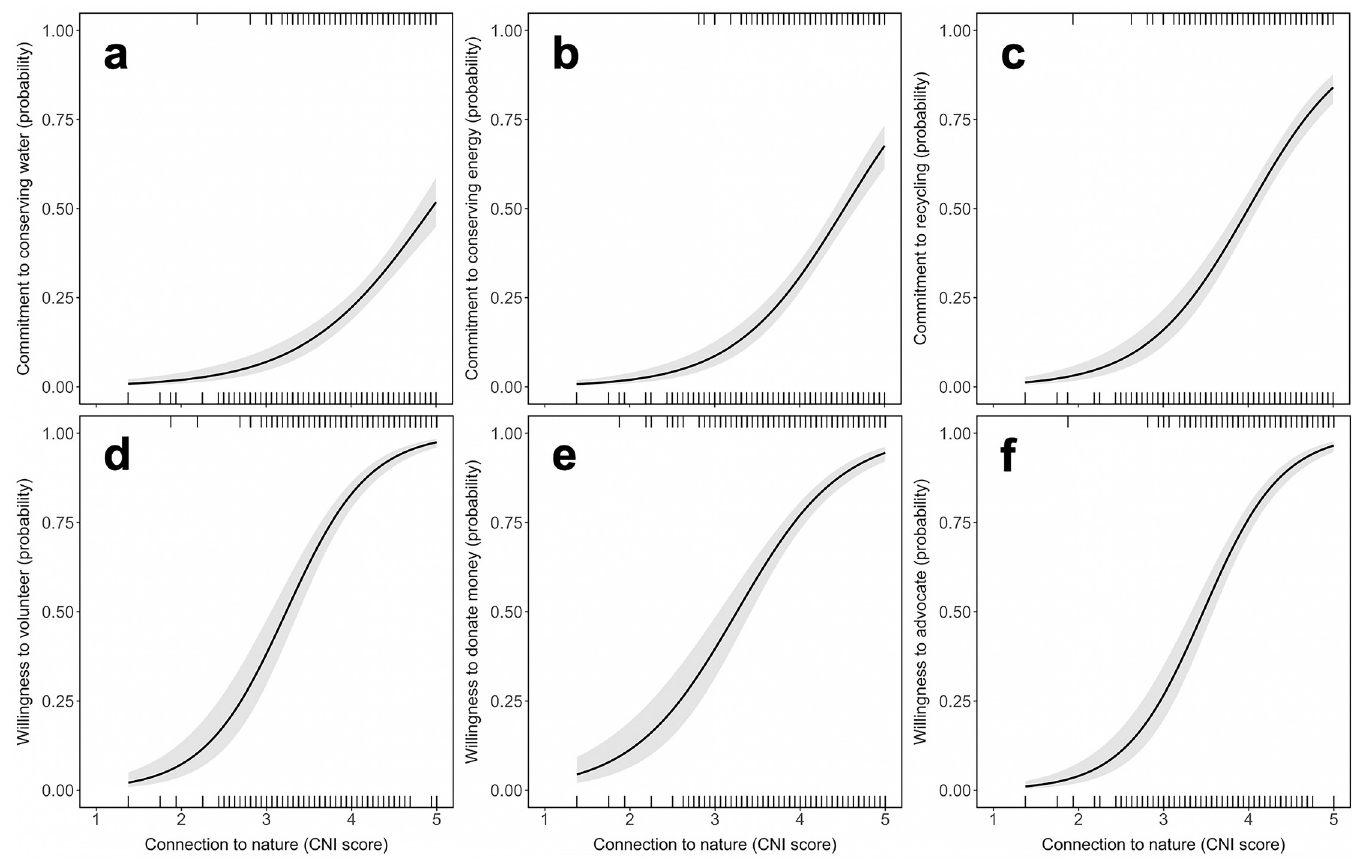
Fig 3. Probability indicating (a–c) commitment to environmental behaviors and (d–f) willingness to conserve nature, graphed as a function of Connection to Nature Index scores. Trend lines show conditional means with 95% CI shaded. Rug lines denote the positions of positive and negative residuals. N = 1,037.